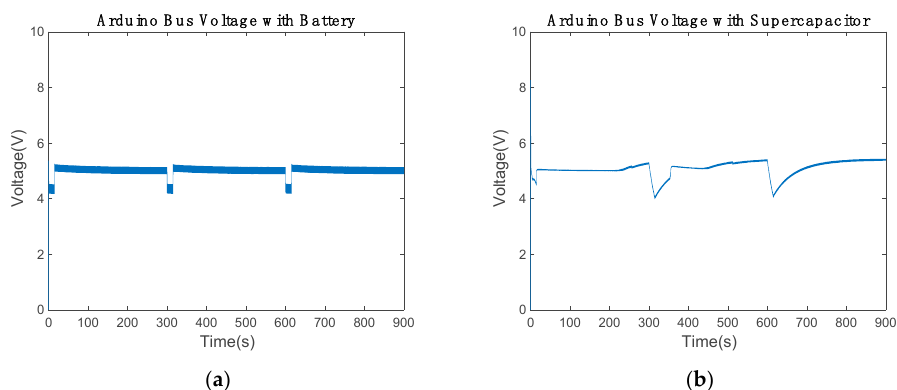
Figure 16. Arduino bus voltage with inductance minimization: ( a ) using the battery and ( b ) using the